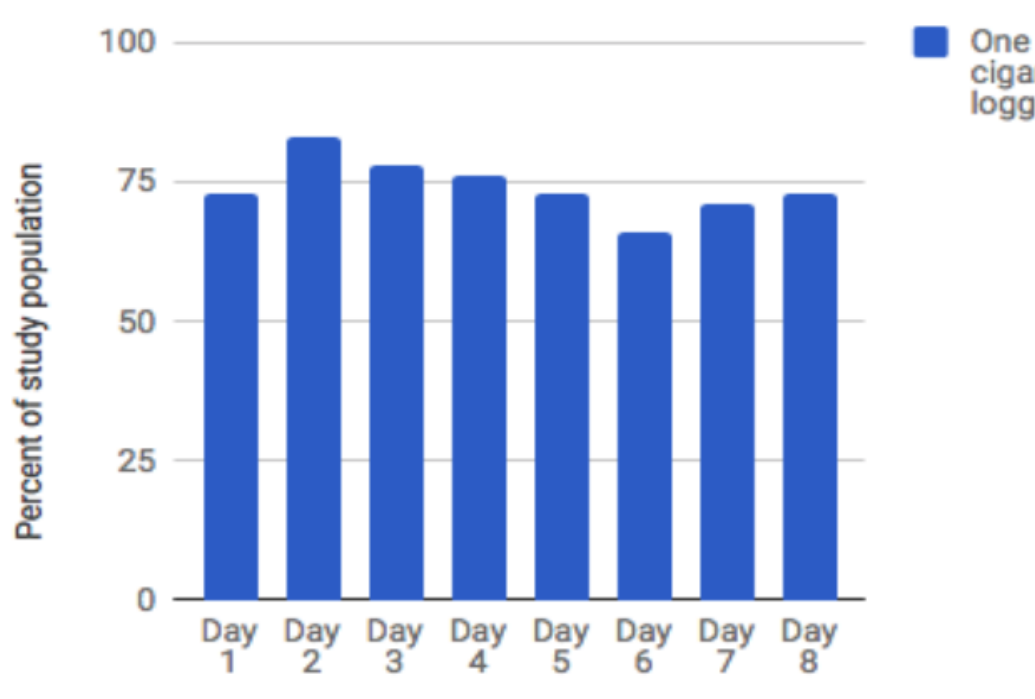
Figure 7. Percentage of study population logging at least one cigarette on each day.